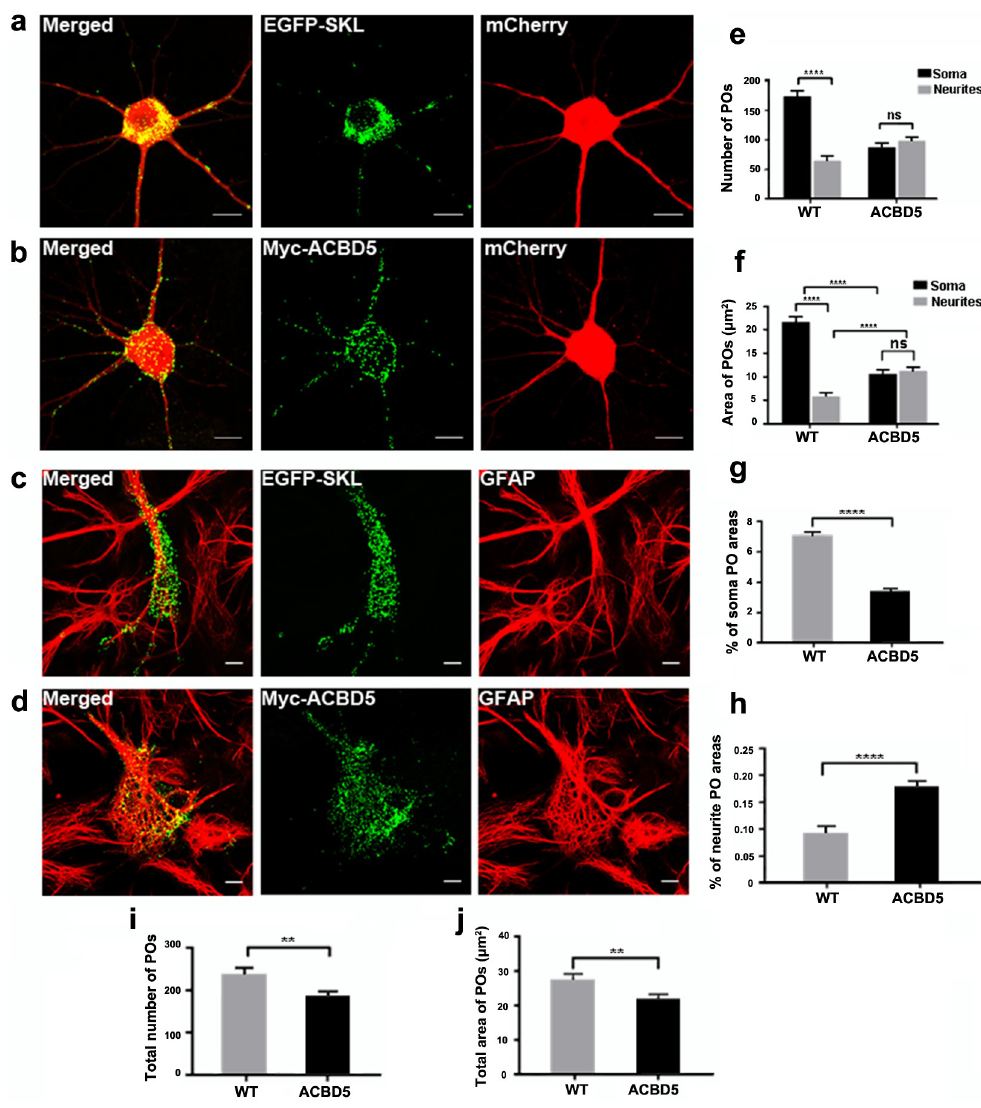
Fig 3. PO morphology and distribution in primary hippocampal neurons in response to the overexpression of myc- ACBD5. (a, b) POs in neurons co-transfected with plasmids encoding cytosolic mCherry as well as (a) EGFP-SKL and (b) myc-ACBD5 respectively. (c, d) PO distribution in astrocytes of the primary hippocampal cultures with (d) or without (c) myc-ACBD5 expression. Astrocytes were identified by GFAP immunostaining. Note that POs in astrocytes unlike in neurons are similarly distributed in both conditions. (e) PO numbers and (f) area distribution ( μ m 2 ) in the soma and neurites (proximal 30 μ m). (g, h) Percentage areas of POs in soma (g) and neurites (h) (proximal 30 μ m). (i) Total PO number and (j) area covered by POs in transfected neurons. Representative immunofluorescence images are presented as maximum intensity projections (scale bar: 10 μ